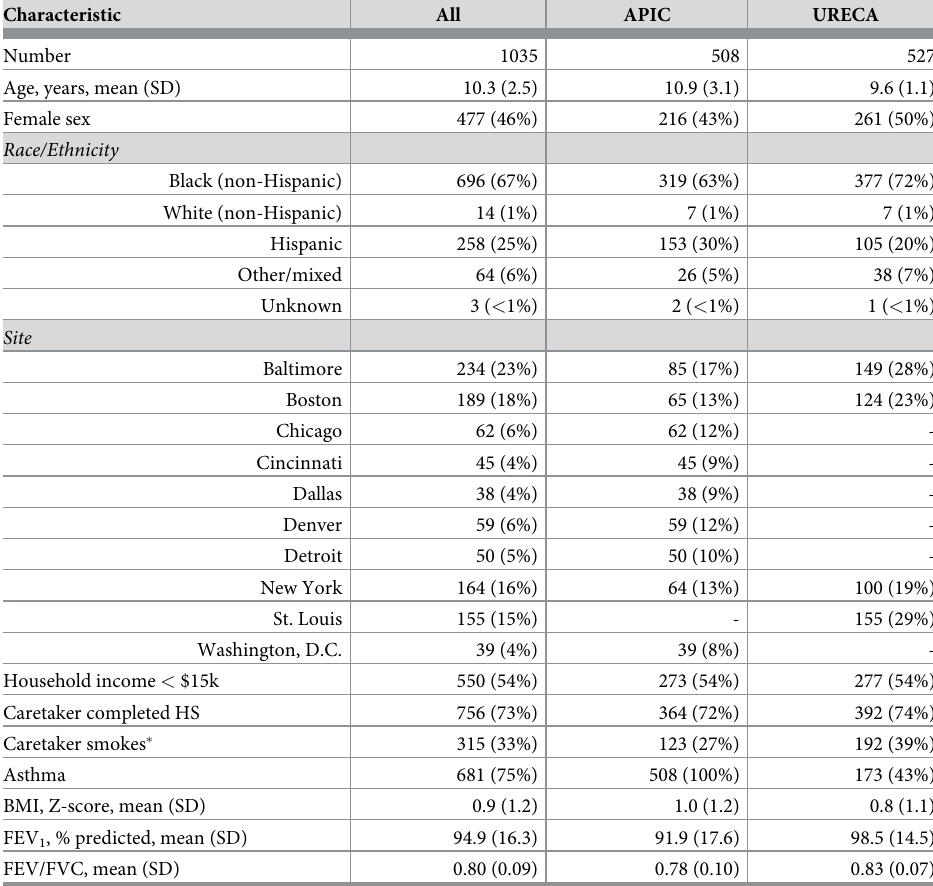
Table 1. Demographic characteristics of sequenced APIC and URECA participants. Characteristic